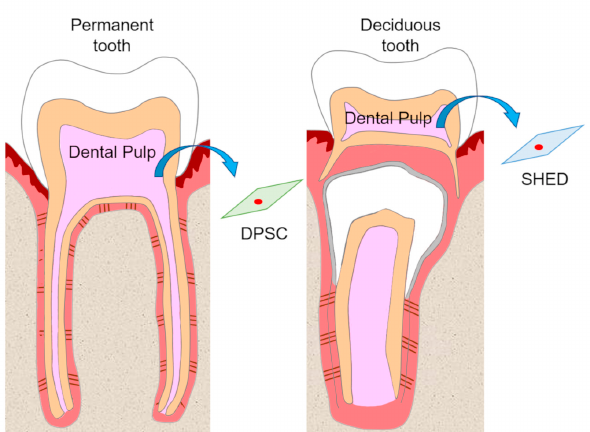
Figure 1. Isolation of dental pulp stem cells (DPSCs) and stem cells from human exfoliated deciduous teeth (SHEDs). DPSCs and SHEDs isolated from pulp tissue of permanent teeth and deciduous teeth, respectively, have the potential to be cell sources in regenerative medicine.